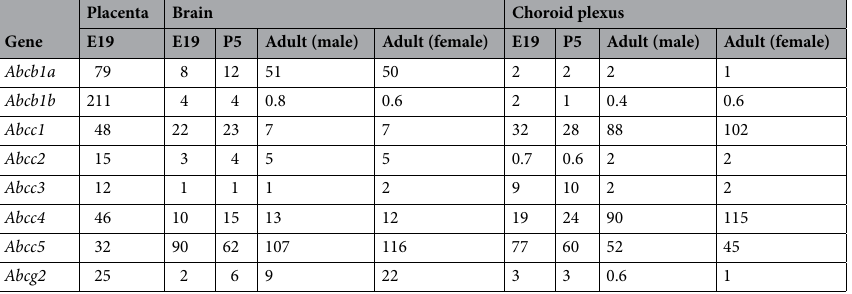
Table 2. Expression of key ABC transporters associated with drug efflux at placental and blood–brain barriers in control tissue. Values are average counts per million (CPM; n = 4) measured by RNAseq and analysed using